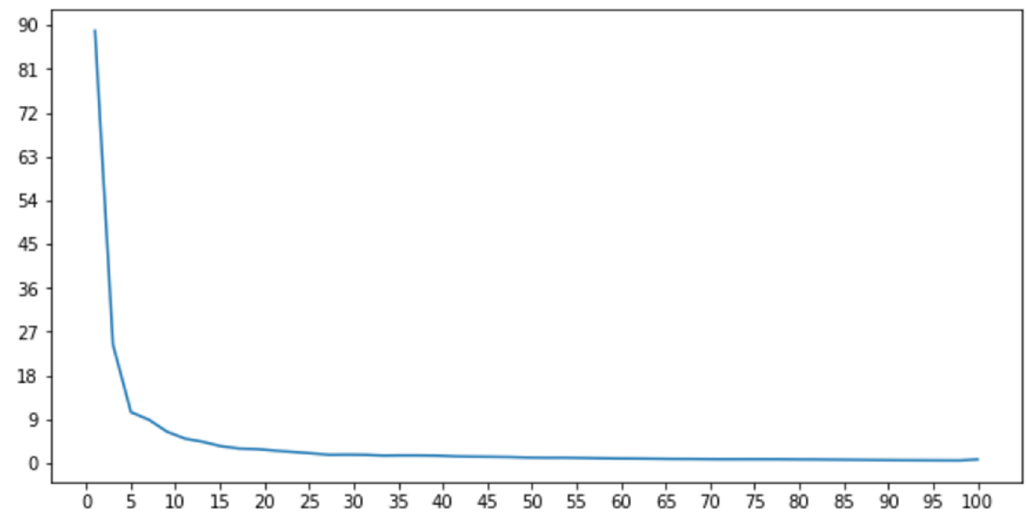
Figure 11 . Skaq percentiles comparison to random baseline for su (4) . x -axis denotes the percentile and y -axis the ratio of the percentage of solutions (out of 225) in that percentile over ( q %) 2 . We note that in low percentile 1 − 5 territory, our data exhibits a strong skaq signal by having ∼ 90 − 9 times relatively more entries than the random baseline.